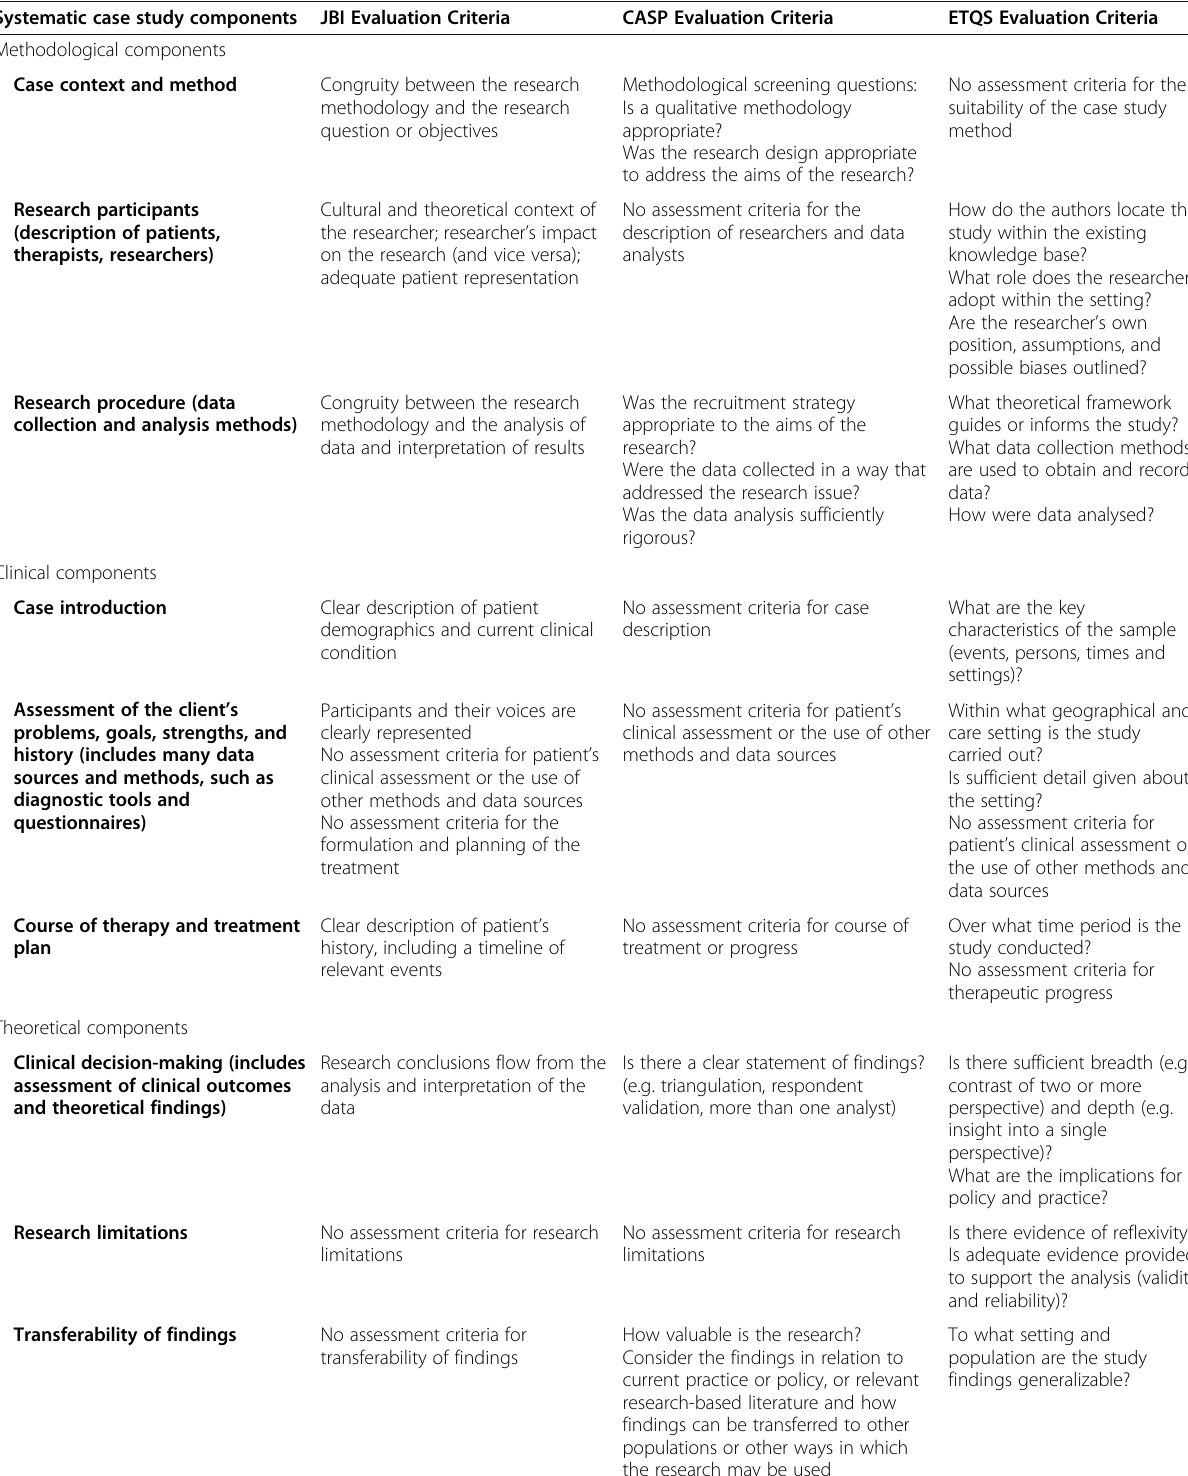
Table 9 Comparing the relevance of JBI (Joanna Briggs Institute), CASP (Critical Appraisal Skills Program) and ETQS (Evaluation Tool for Qualitative Studies) for appraising components specific to systematic case